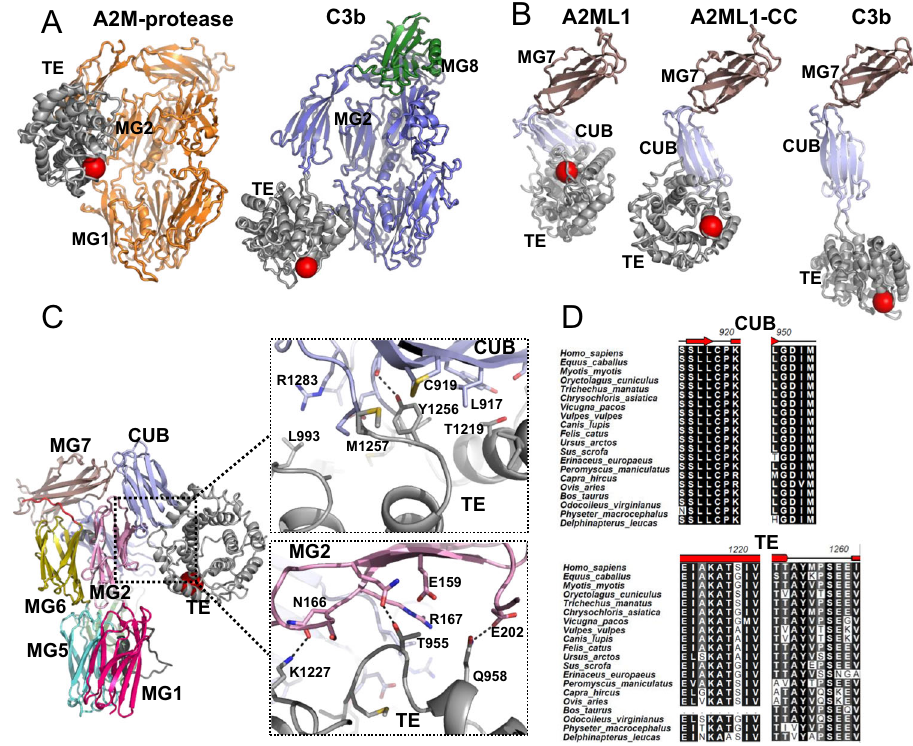
Fig. 4 In cleaved A2ML1, the thioester and CUB domains associate through a conserved hydrophobic interface. A Conformation of the monomer from the A2M-MA tetramer and C3b for comparison with A2ML1 in Fig. 3E with the thioester glutamines indicated by the red spheres. In both A2ML1 and A2M, the TE and MG2 domains interact, whereas in C3b, the TE domain is instead adjacent to the MG1 domain. Notice the green MG8 domain in C3b that is stably associated with the remaining parts of C3b. A unique C-terminal domain in C3b, C345C, is not shown. B Comparison of the conformation of the MG7-CUB-TE domains in A2ML1, A2ML1-CC, and C3b. All structures were superimposed through their MG7 domains to emphasize the movement of the CUB and TE domains upon proteolytic activation of A2ML1 and C3. C Expanded views of the interactions formed by the TE domain with the CUB and MG2 domains, top, and bottom, respectively. Putative polar interactions are indicated by dotted lines. D Alignment of regions of the CUB and TE domains in mammalian A2ML1 supports that the interface is very highly conserved. The full alignment is presented in Supplementary Fig.